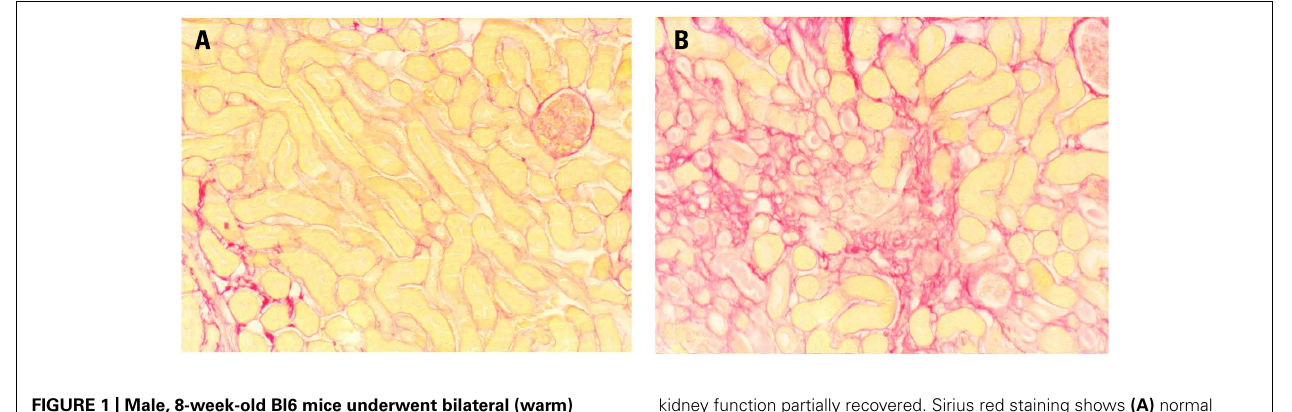
FIGURE 1 | Male, 8-week-old Bl6 mice underwent bilateral (warm) renal ischemia for 25 min by clamping of the renal artery and vein. Long-term structural damage and fibrosis were assessed. I/R injury induced severe patchy renal fibrosis three weeks after ischemia, although